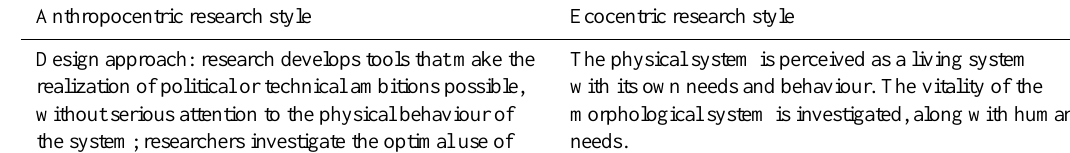
Table 4. Contrasting research styles to deal with physical systems.